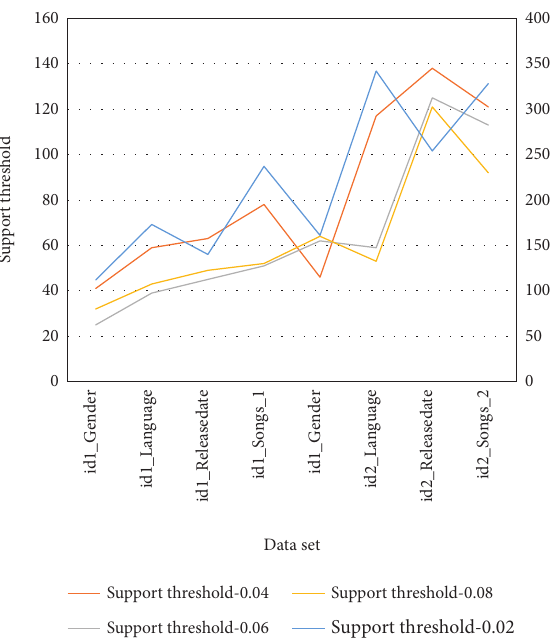
Figure 5: Frequent set mining results under different tourism data sets.